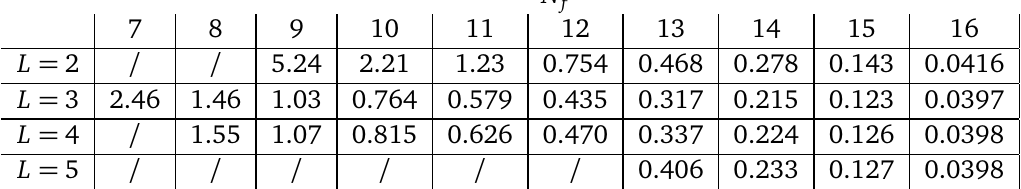
in the SU ( 3 ) hyper-color f